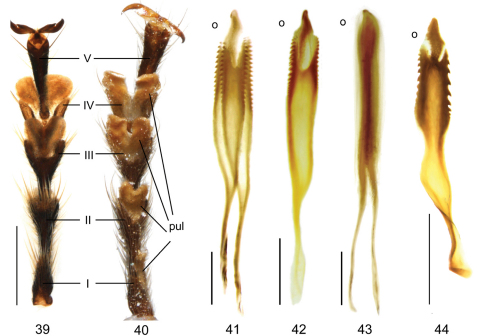
Metatarsus 39 Tillicera sensibilis, paratype, separated from body and treated with KOH 40 Tillicera wenii, holotype, left leg in natural condition. The Roman numerals indicate the segment of the tarsus. pul = pulvillus. Scale = 0.5mm 41–44 Phallus 41 Tillicera bibalteata, from Yunnan 42 Tillicera hirsuta, from Tonkin 43 Tillicera michaeli, from Hainan 44 Tillicera cleroides, from Hainan. o = median orifice. Scale = 0.5mm